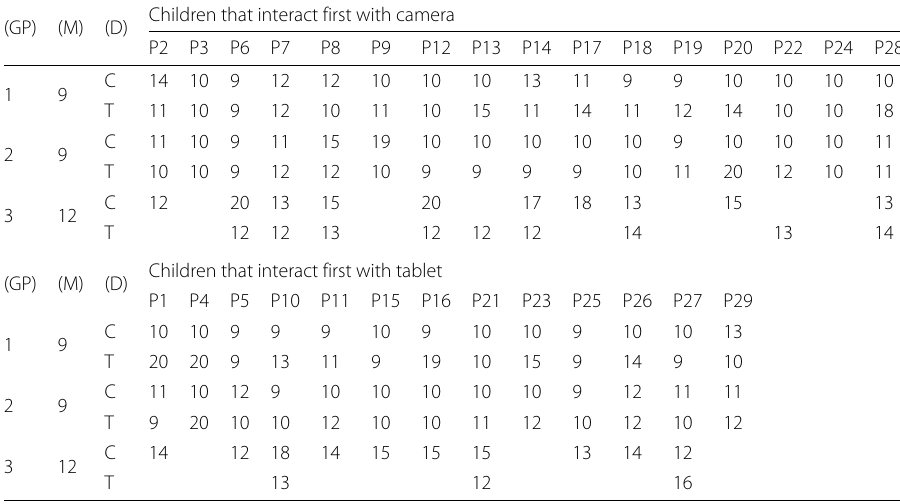
Table 2 Number of movements (hand gestures or touch) by Participant (P) per game phase (GP) in each Device (D), (M) - minimum number of movements to achieve the phase goal Children that interact first with camera (GP) (M) (D) P2 P3 P6